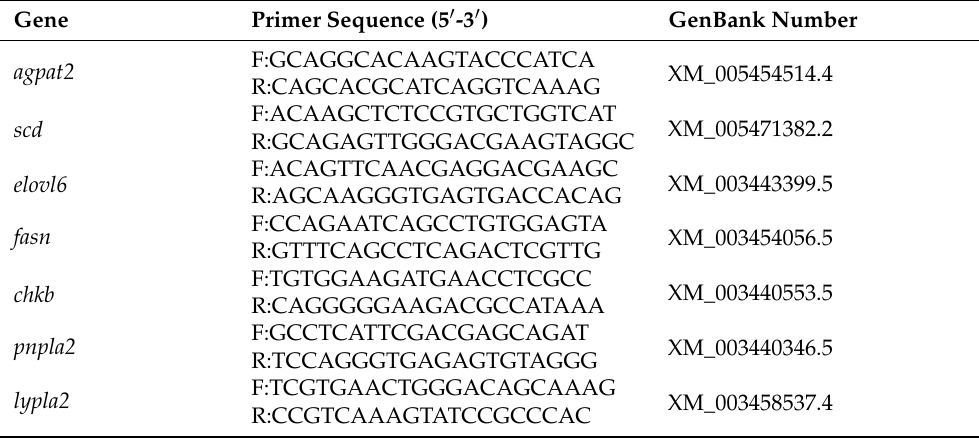
Table 1. Specific primer sequences used for qPCR analyses in this